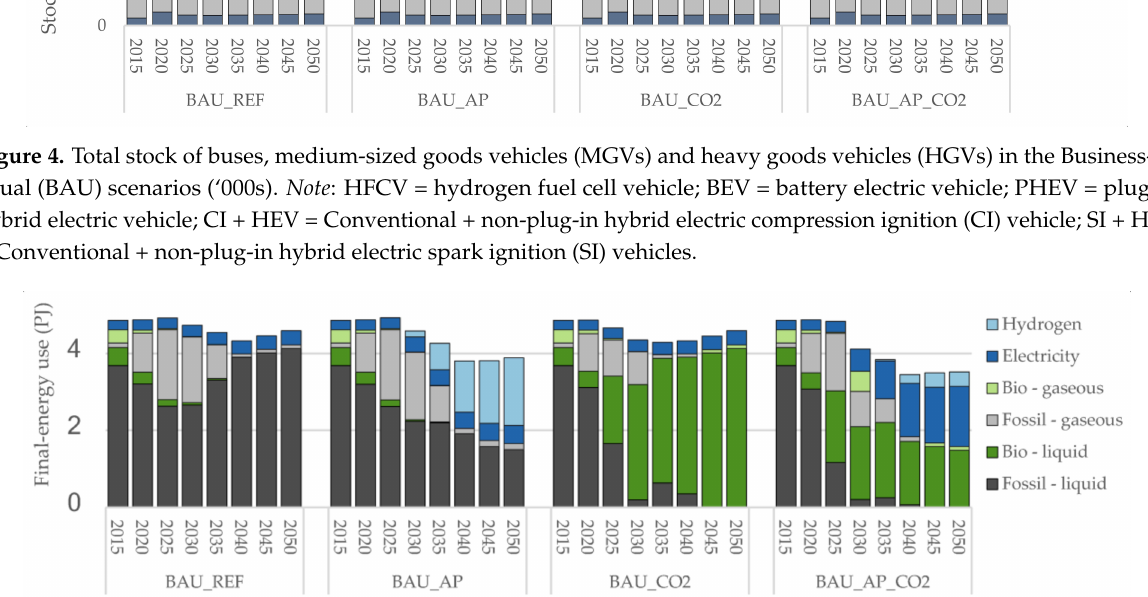
Figure 5. Total final-energy use by fuel type in the Business-as-usual (BAU) scenarios